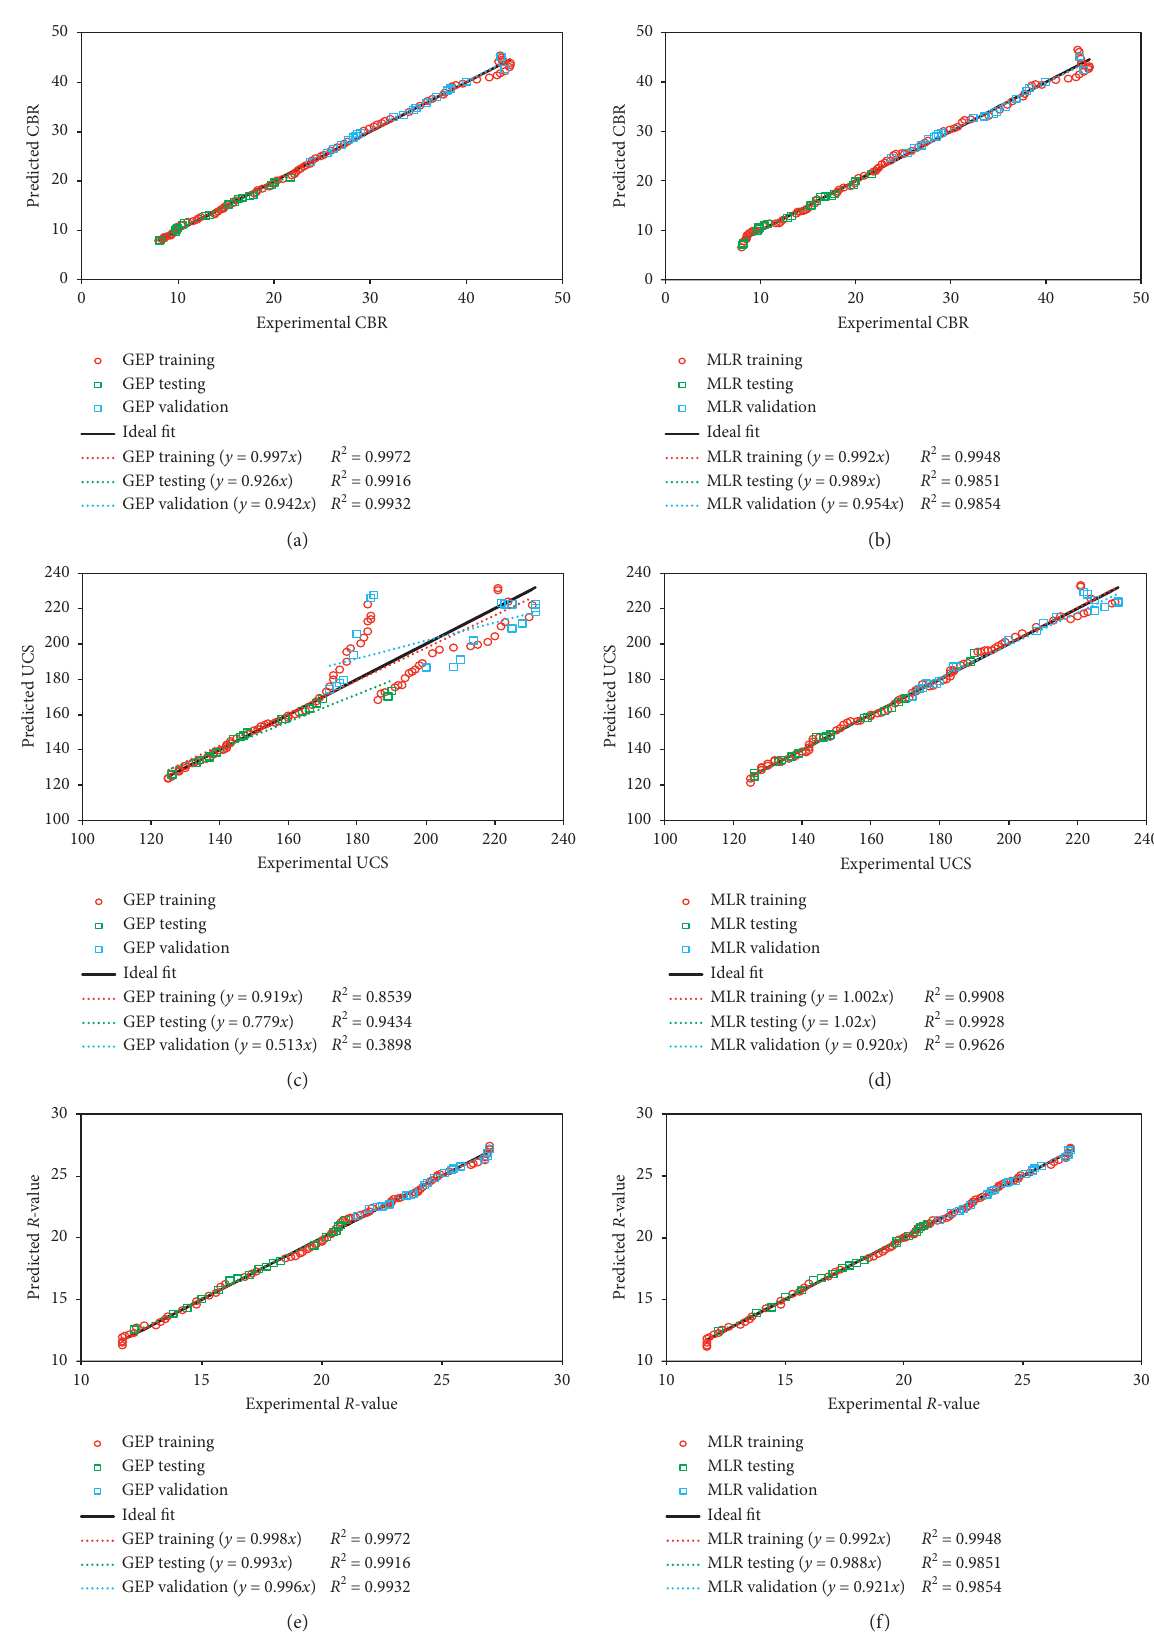
Figure 10: Experimental versus predicted values of CBR, UCS, and R values for models formulated using GEP and MLR,